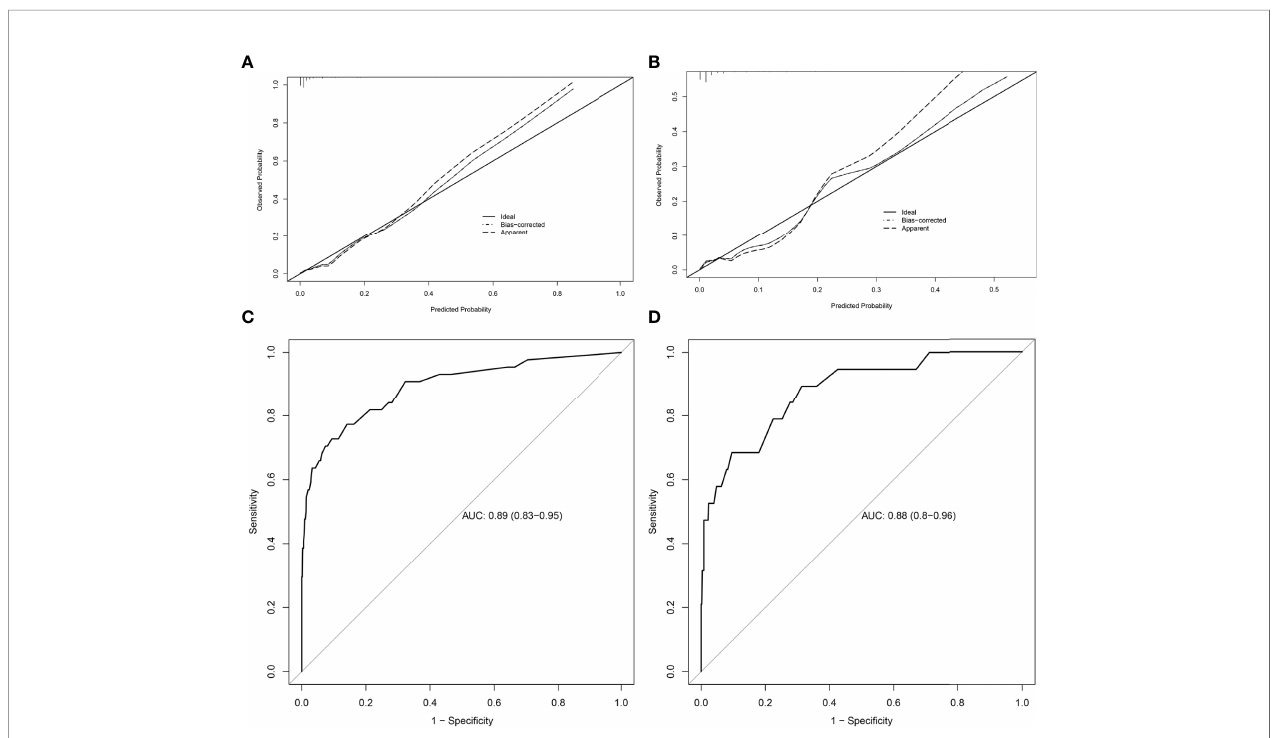
FIGURE 5 | Evaluation of the LRR nomogram (A – D) . Calibration curves for the nomogram in the training cohort (A) and validation cohort (B) . The x -axis shows the predicted probability of an LRR event. The y -axis shows the actual LRR outcome. The discrimination assessed by ROC curves for the nomogram in the training cohort (C) and validation cohort (D) . The AUCs for LRR prediction were 0.89 (95% CI = 0.83, 0.95) in the training cohort and 0.88 (95% CI = 0.8, 0.96) in the validation cohort. LRR, local – regional recurrence; ROC, receiver operating characteristic; AUC, area under the